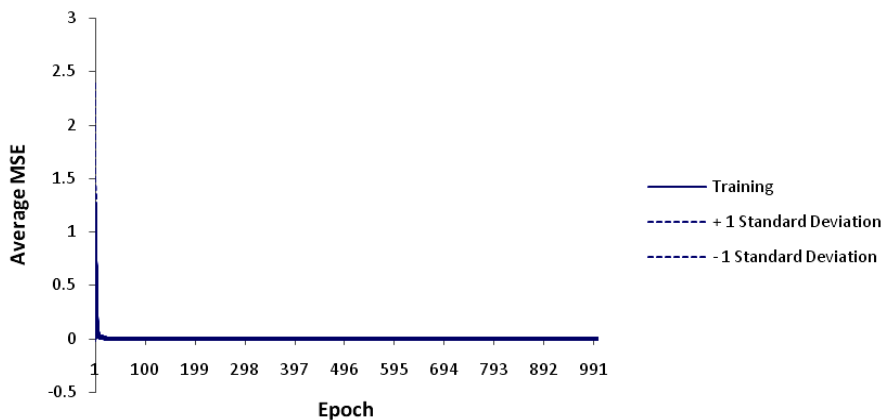
Figure 3. Average MSE for the ANN trains with standard deviations for 10,000 epochs.